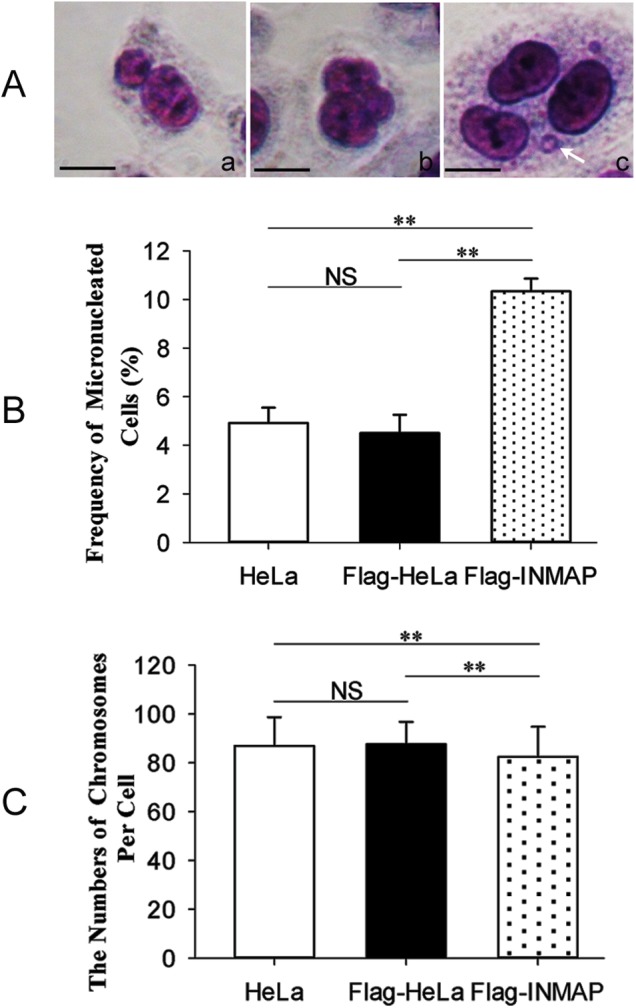

INMAP overexpression induces genomic instability in HeLa cells.(A, B). The effect of INMAP overexpression on the induction of micronuclei. (A). Mono-, bi- and tri-nucleated cells, stained with Giemsa. Arrowhead indicates micronucleus. (B). The frequency of micronucleated cells in Flag-INMAP cells (n = 400) is greater than in Flag-HeLa or HeLa. (C). The numbers of chromosomes were determined in INMAP-overexpressing cells (n = 100). Scale bars, 5 μm.